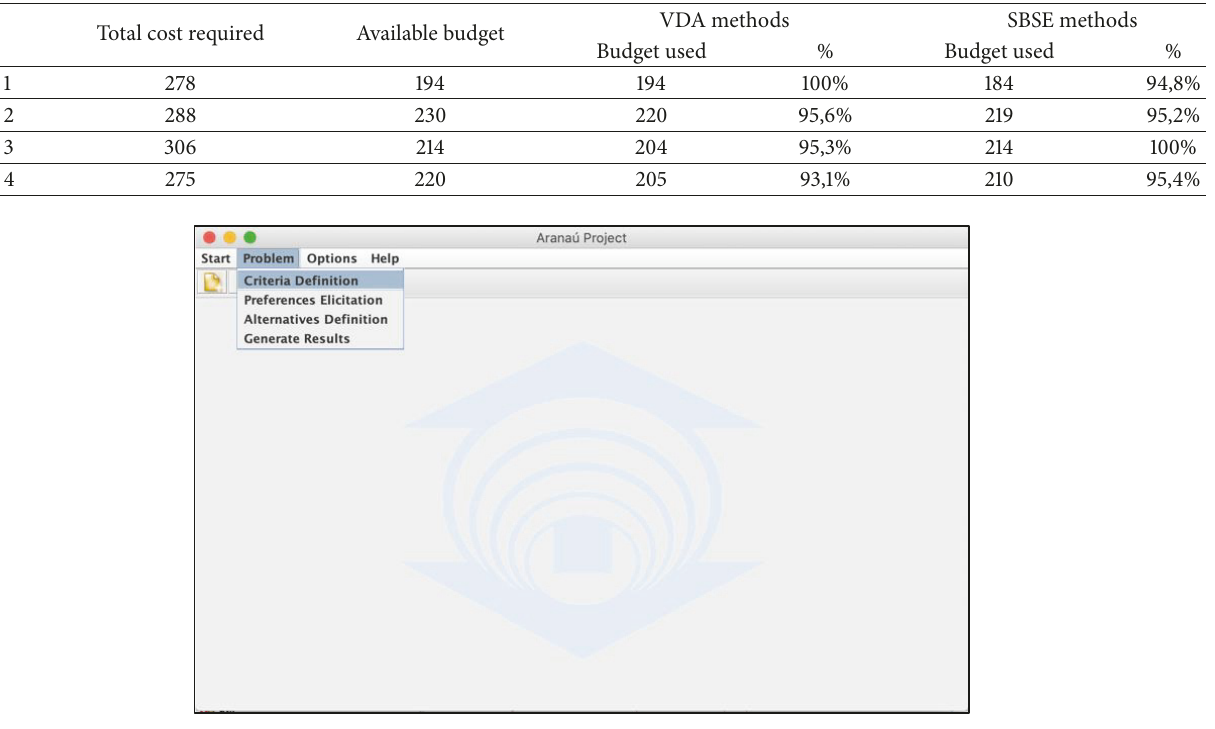
Figure 9: Arana´u tool.